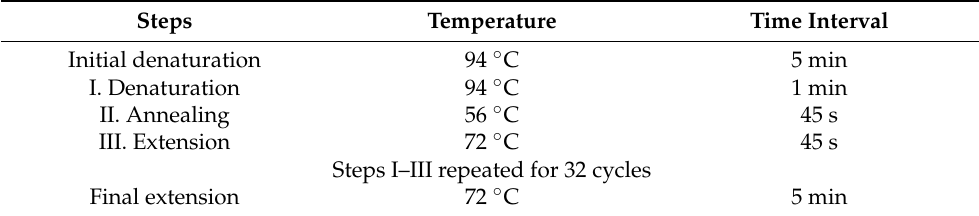
Table 3. PCR cycle